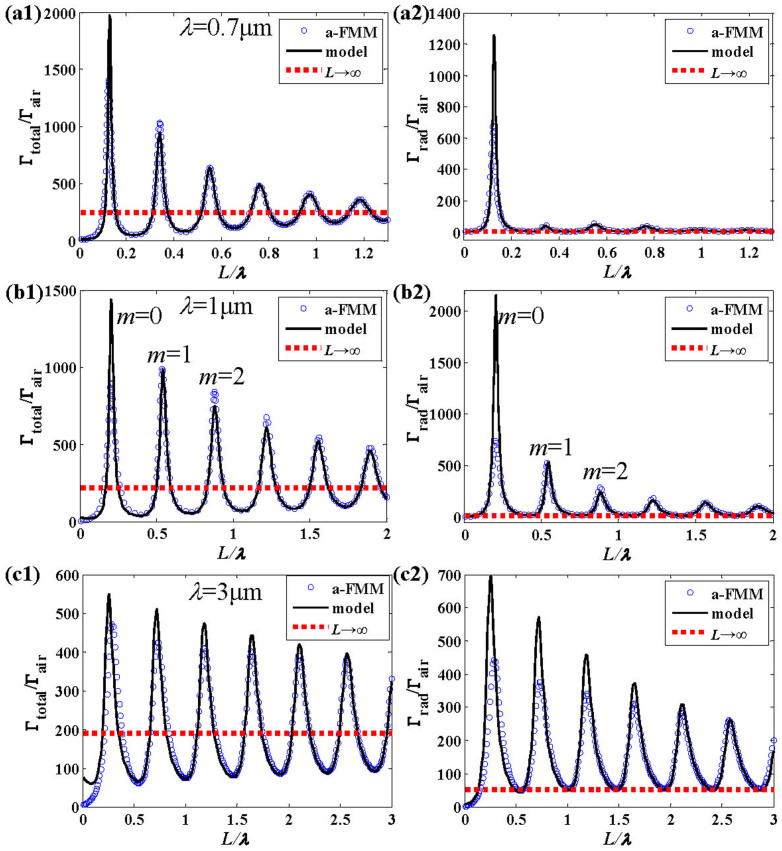
Total (Γtotal in the left column) and radiative (Γrad in the right column) emission rates of the dipole antenna plotted as functions of antenna length L.Γtotal and Γrad are normalized by the emission rate Γair of a dipole source in air. The horizontal dotted lines show the results for antennas with infinite-length arms (L→∞). The results are obtained for wavelengths λ = 0.7 μm (a1)–(a2), 1 μm (b1)–(b2) and 3 μm (c1)–(c2), respectively. Other parameters are D = 0.04 μm and w = 0.03 μm. The complex effective index of the SPP mode is neff = 2.3691 + 0.1066i, 1.4824 + 0.0352i, 1.0819 + 0.0108i for λ = 0.7 μm, 1 μm, 3 μm, respectively. (1.5 column)